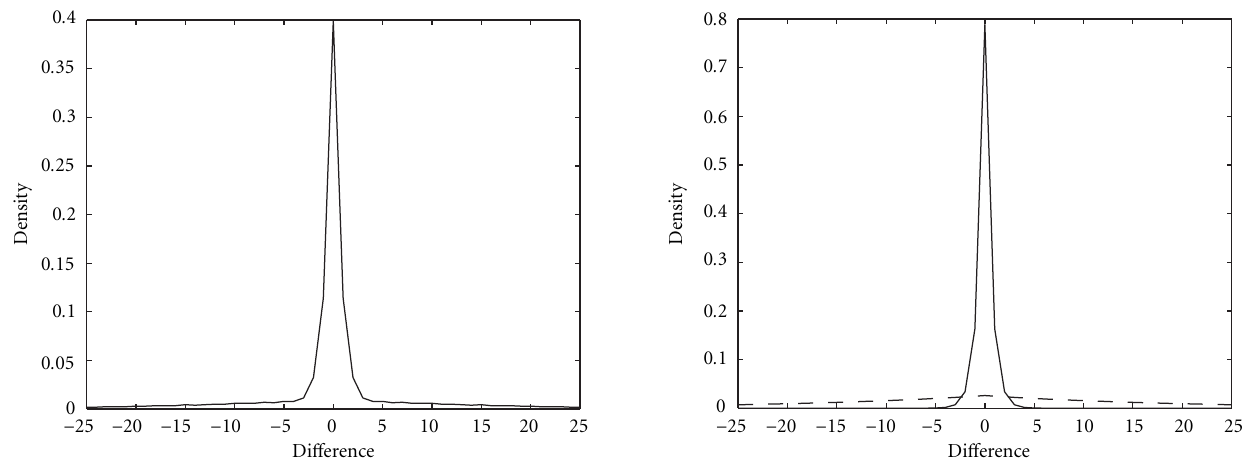
Figure 3: Mixture decomposition in Laplacian distributions for the inter-frame di ff erence ( Erik